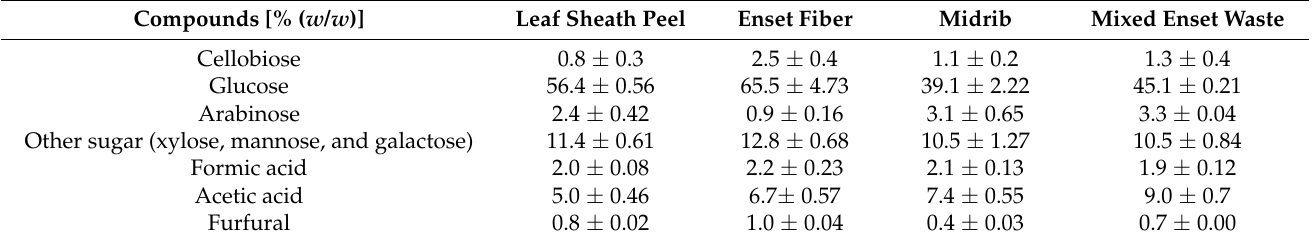
Table 3. Sugars and degradation products in liquid hydrolysate of Enset biomass parts after two-step acid hydrolysis. Values are given in % weight per weight dry Enset biomass